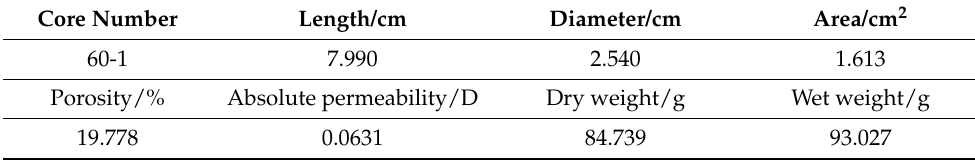
Table 2. Basic data of the core.